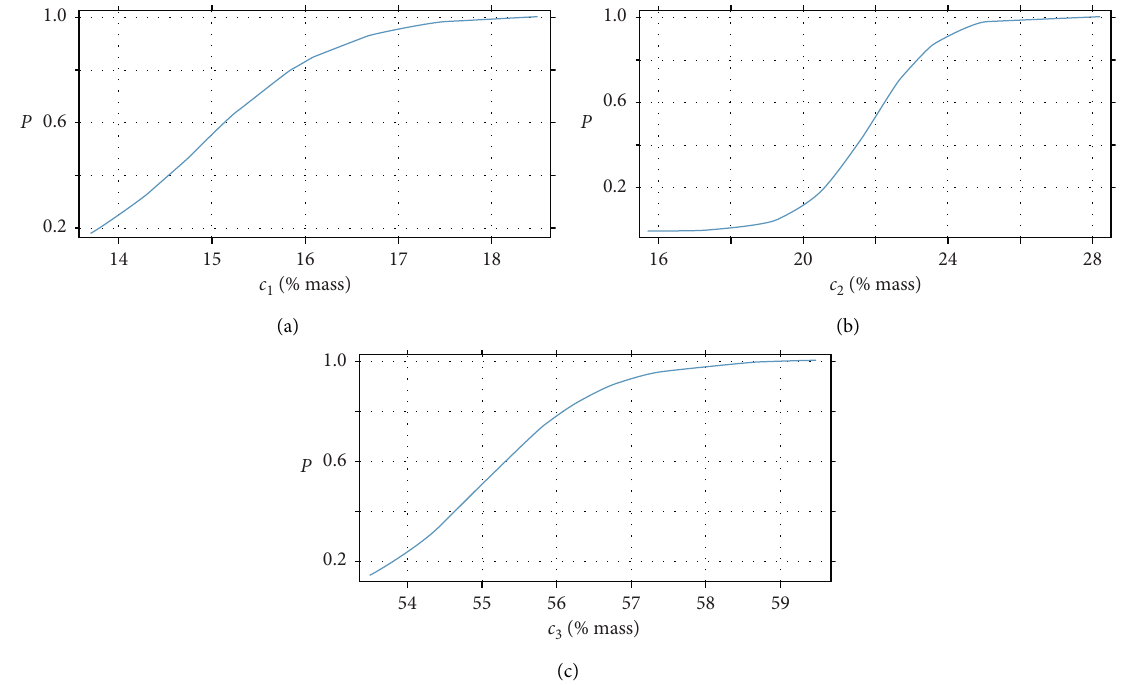
Figure 3: Probabilities P ( l � 5) of responses on consistency in dependence on content of (a) protein c fractions, %. Each plot is calculated at contents of other main components equal to their observed mean values in Table 4.